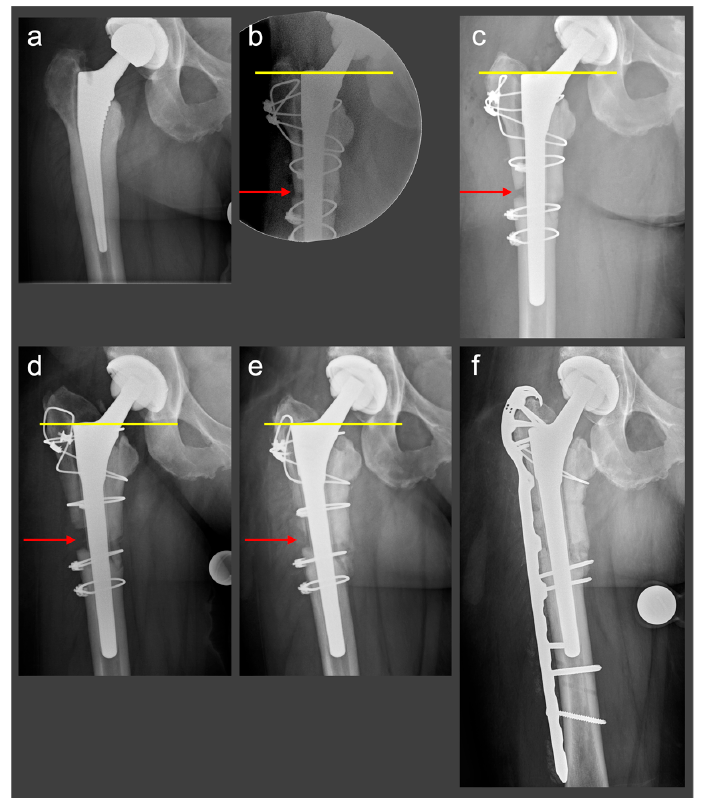
Figure 3. Case of a patient with a trochanteric escape after ETO. ( a ). Two years after implantation of a fully coated non-cemented stem, the patient presented with an early aseptic stem loosening. Metaphyseal radiolucency and the diaphyseal cortical hypertrophy are seen, indicating a lack of metaphyseal osteointegration with a diaphyseal mechanical bone stress. ( b ). Intraoperative images: An ETO was performed for stem removal. The osteotomy was reduced and fixed with three horizontal cable cerclages and one combined vertical and horizontal cable fixation. An intraoperative fracture of the medial cortex occurred. ( c ). Three days postoperatively, after patient mobilization: note trochanteric escape with a loss of reduction of the osteotomy fragment (red arrow) and proximal migration of the trochanter fragment (yellow line outlines the shoulder of the prosthesis, which is now level with the tip of the cerclage). ( d ). Three months postoperatively: note further cranial dislocation of the trochanter fragment causing a larger osteotomy gap (red arrow). The tip of the vertical cerclage is now clearly above the shoulder of the prosthesis (yellow line). ( e ). Five months postoperatively: no healing tendency at the osteotomy gap is seen (red arrow). ( f ). The symptomatic non-union was treated with an open reduction and internal fixation of the fragment with a periprosthetic plate.